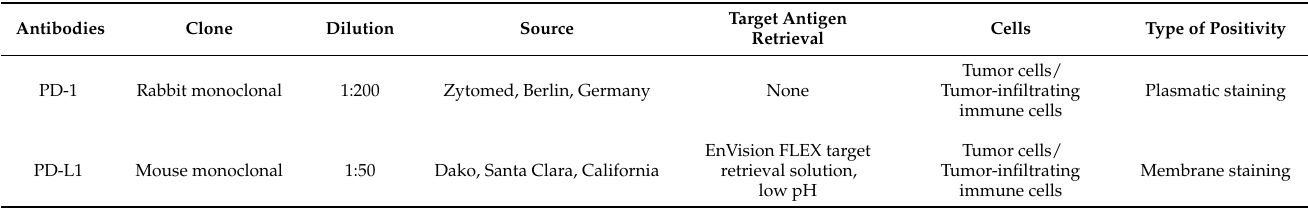
Table 2. Antibodies used for the immunohistochemical